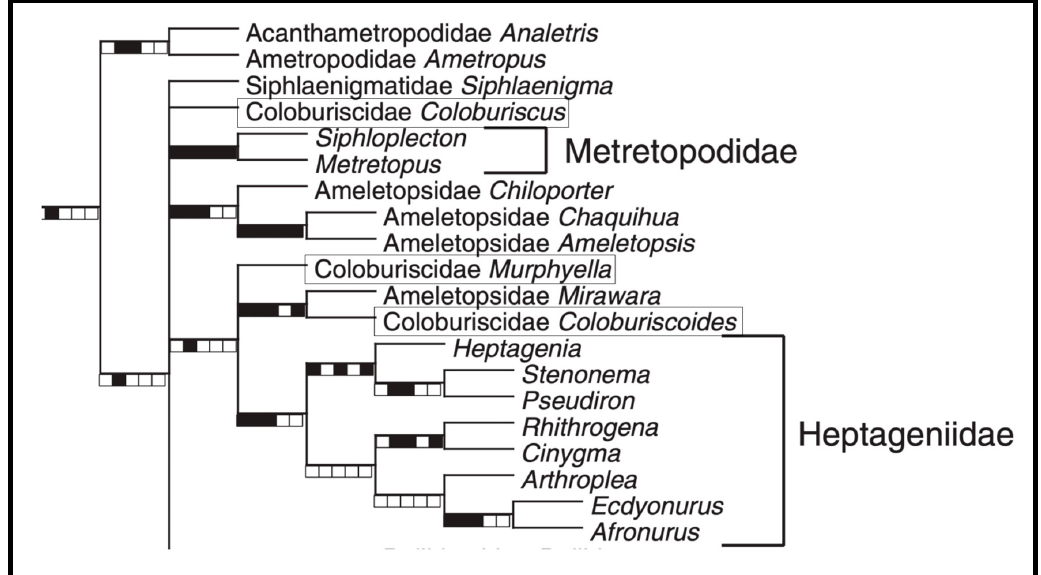
Figure 1. Maximum likelihood results from Figure 2 of Ogden et al. (2009) [5], showing non-monophyly of Coloburiscidae. The boxes are filled in (from left to right) if bootstrap value > 90 (box1), Bremer support value > 2 (box 2), Bayes posterior probability > 90 (box 3), node present when gaps + 5th state character (box 4), and node present in POY analysis (box 5).